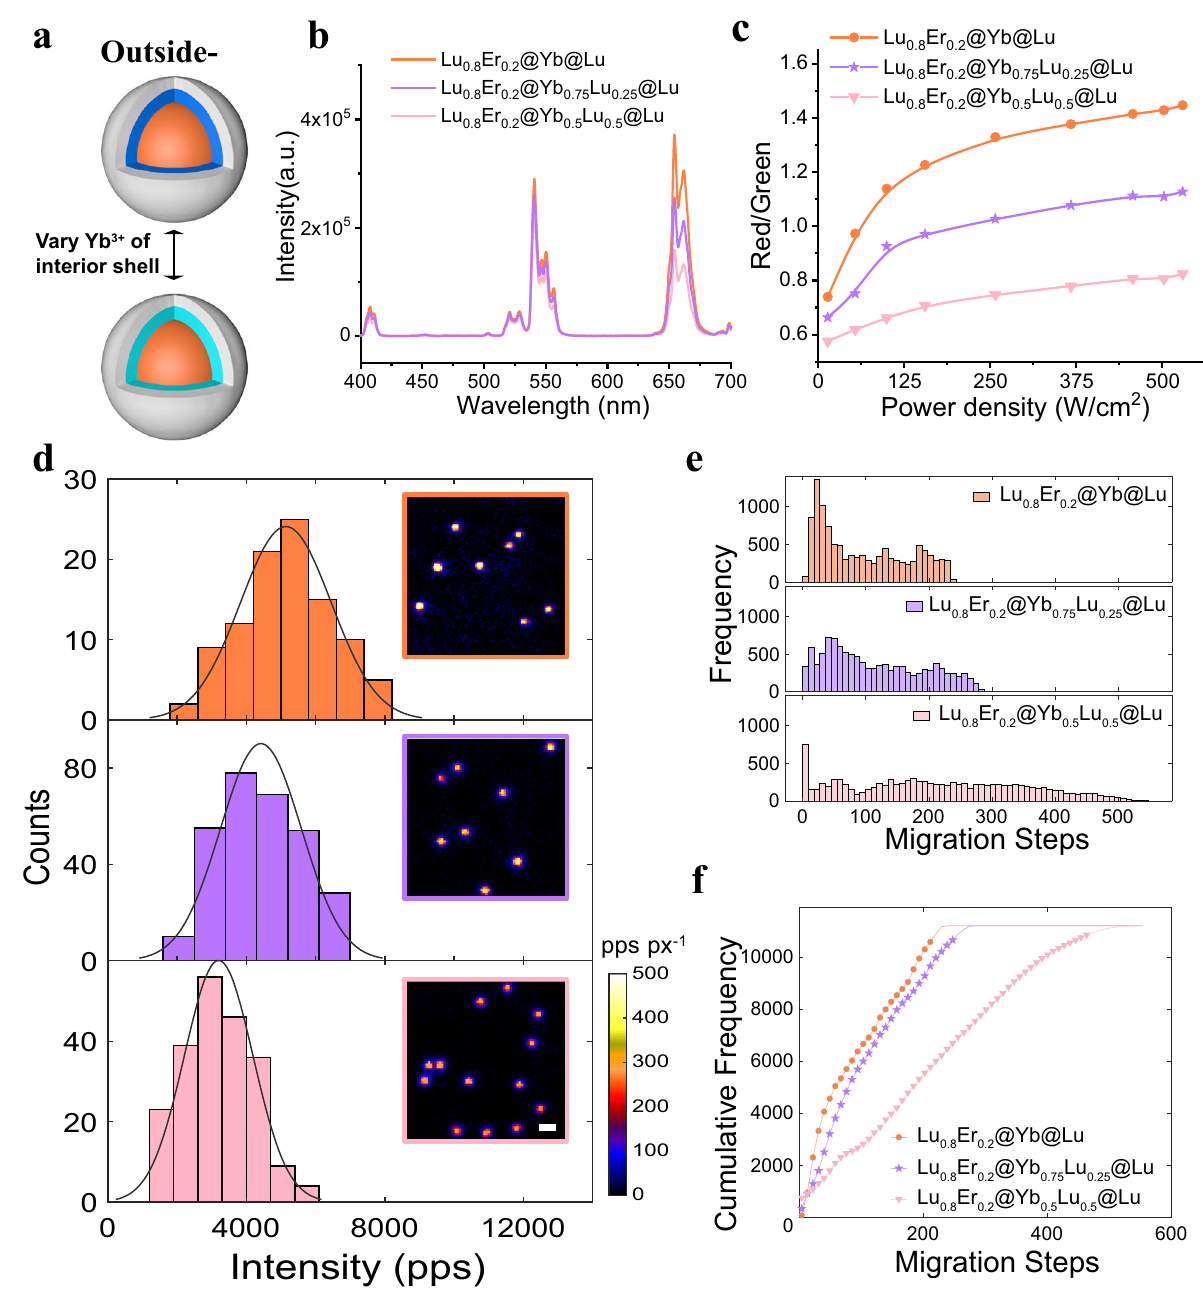
Fig. 5 | Effect ofvarying the dopingconcentration ofYb 3+ ions ininteriorshell. a Schematic diagram of varying the doping concentration of Yb 3+ ions in the interiorshell. b UCLspectraofensemblesolutionunder980nmlaserirradiationat 530 W = cm 2 . c The power dependence of Red-to-Green ratio. The Red-to-Green ratio compares integrated UCL of red emission at 654nm (from 635 to 683nm) with that of green emission peaks at 521nm (from 510 to 534nm) and at 541nm (from 535 to 577nm) . d Single-particle brightness distribution histogram and single-particle luminescent image of UCNPs with different Yb 3+ ions doping at 21.7